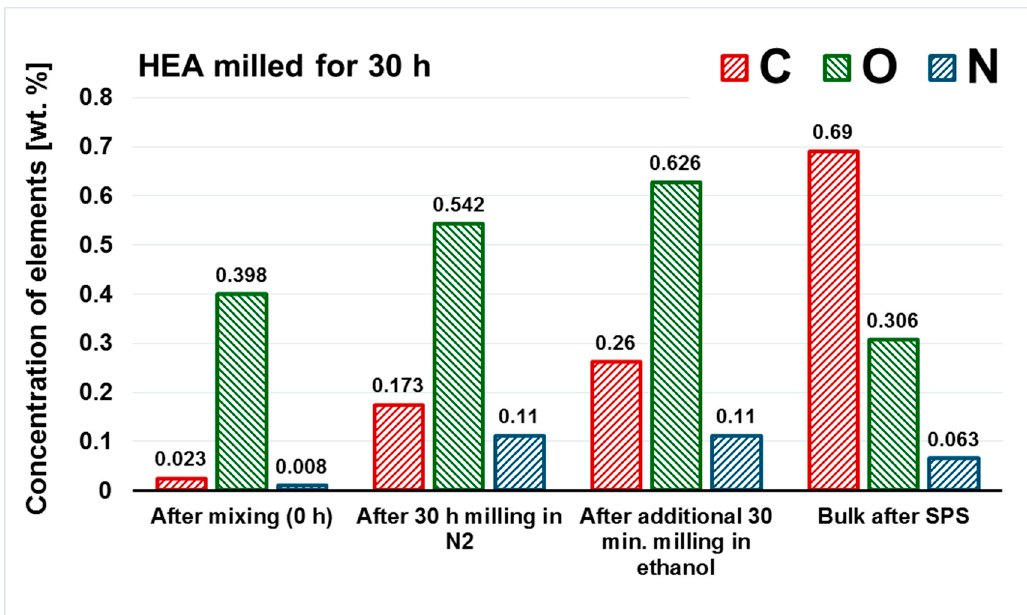
Figure 9. The evolution of contamination in the representative case of HEA powder milled for 30 h and additional 30 min in ethanol. The SPSed bulk was prepared from the powder after 30 h of milling.